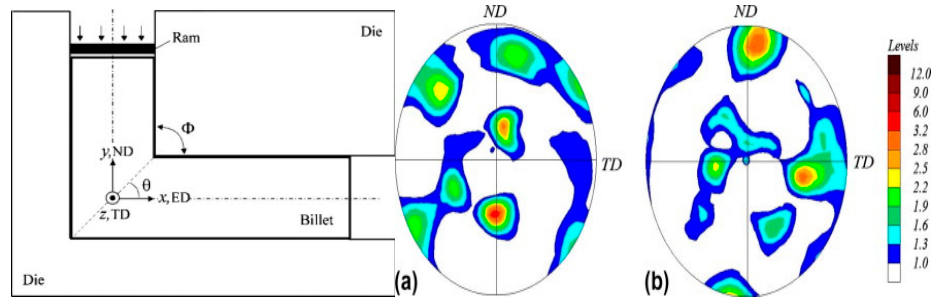
Figure 19. ( a ) ECAP die geometry and coordinate system (1 1 1) and ( b ) (2 0 0) pole figures of Al 7075 alloy subjected to 4 passes of ECAP process by route BC on ED (z) plane [95].